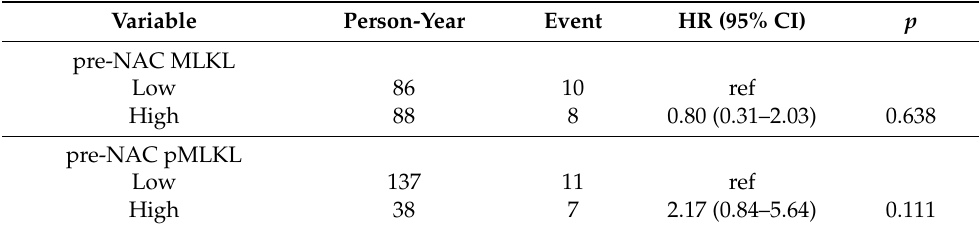
Table 5. Univariate analysis of patients’ 5 year overall survival based on the pre-NAC status of the